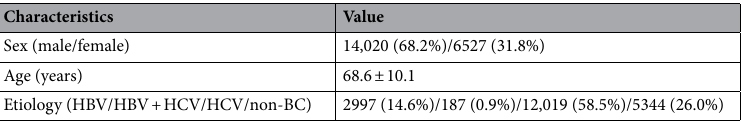
Table 1. Overall patient characteristics ( n = 20,547). Results are expressed as the number (%) or the mean ± standard deviation. Non BC=both hepatitis B surface antigen and HCV-antibody negative.